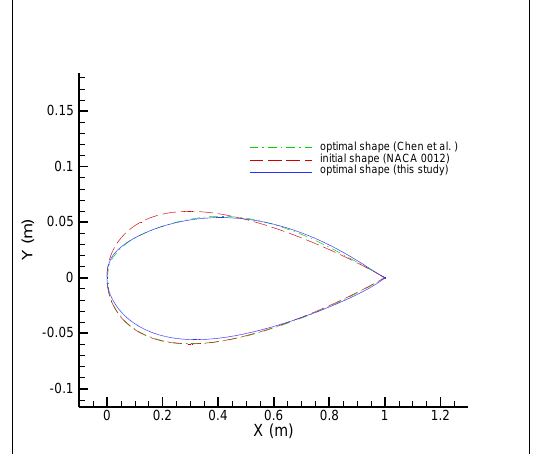
Figure 10. Comparison of the initial shape (NACA 0012), the optimal shape from our study, and the optimal shape from Chen et al. [27]; it shows a good agreement between the optimal shapes and an excellent agreement between the optimal upper surfaces where the shock was eliminated.